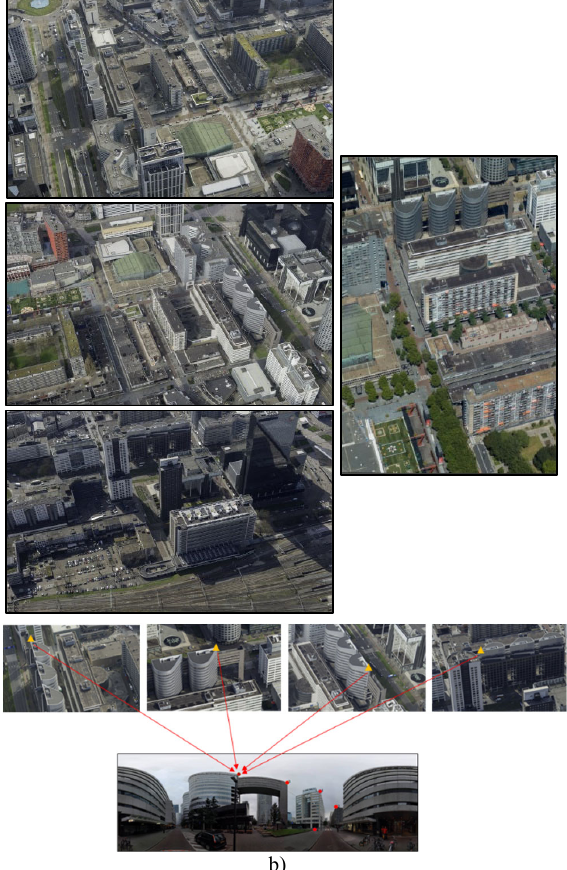
Given: five control points are measured from aerial oblique images (Figure 8) and then their measured pixel coordinates on the MMS panoramic image are measured as shown in Table 3.